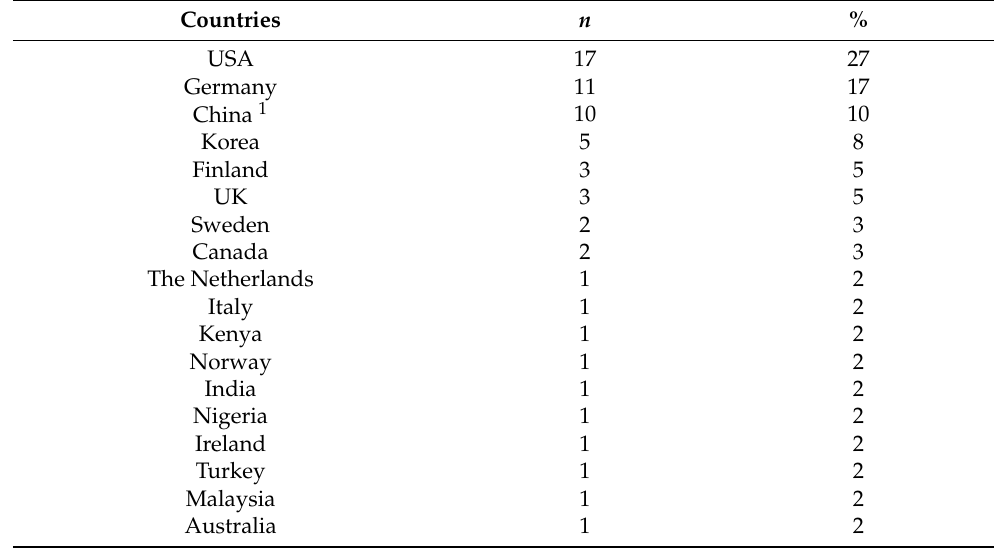
Table 2. Distribution of studies according to countries of implementation or first author